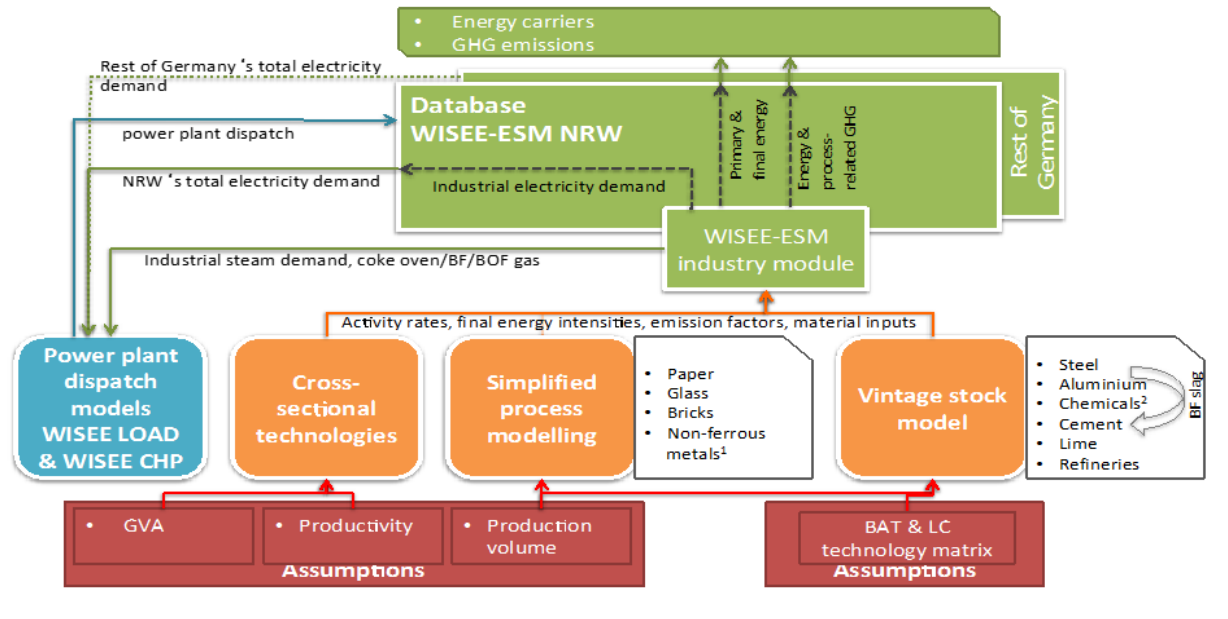
Figure 2. Overview on the WISEE NRW model system (industry focus). Source: